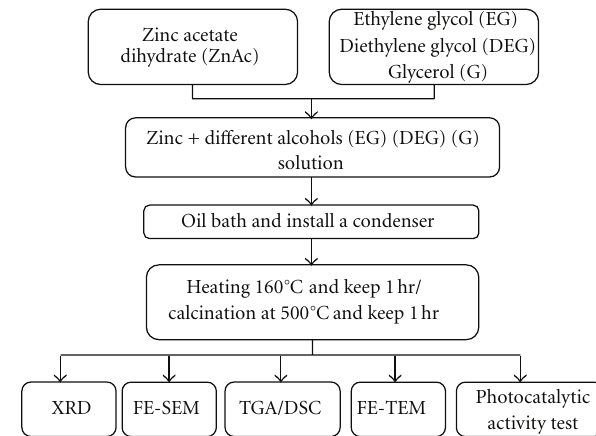
Figure 1: Procedure of the experiment.